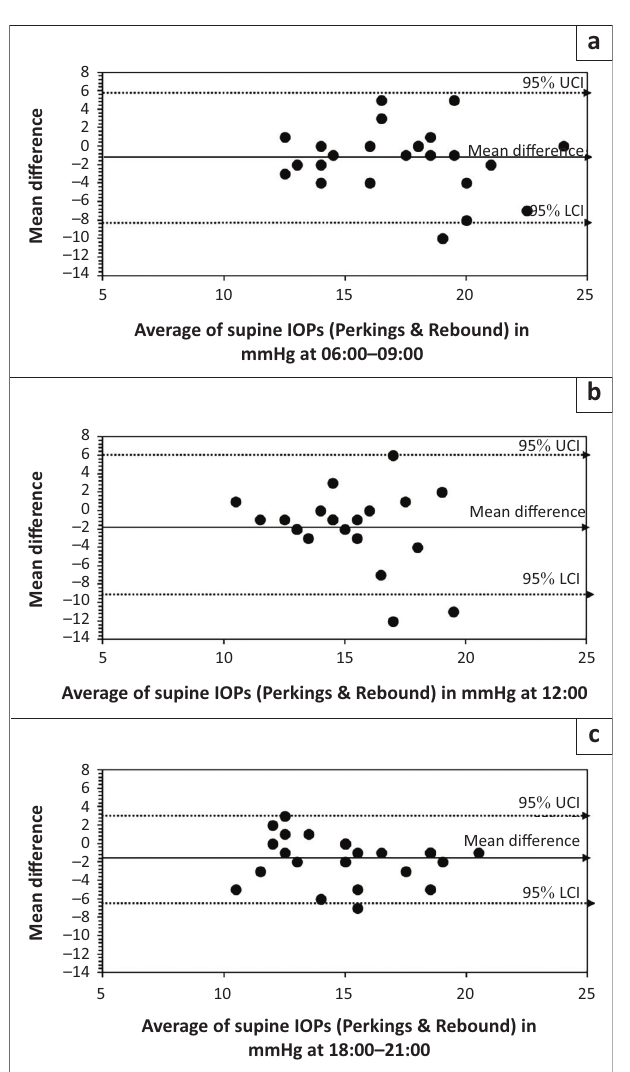
FIGURE 3: Intraocular pressure variations with participants in the supine position. The Bland and Altman plots of agreement in intraocular pressure from iCare and Perkins in the supine position at different times: (a) 06:00–09:00, (b) 12:00–15:00 and (c) 18:00–21:00. The solid line represents the mean difference, whereas the dotted lines represent the upper and lower limits of